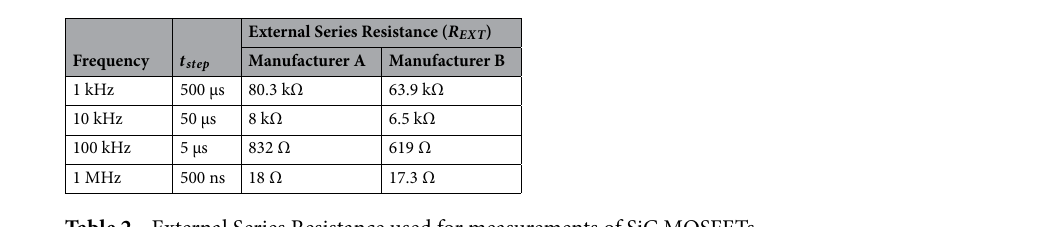
Table 2. External Series Resistance used for measurements of SiC